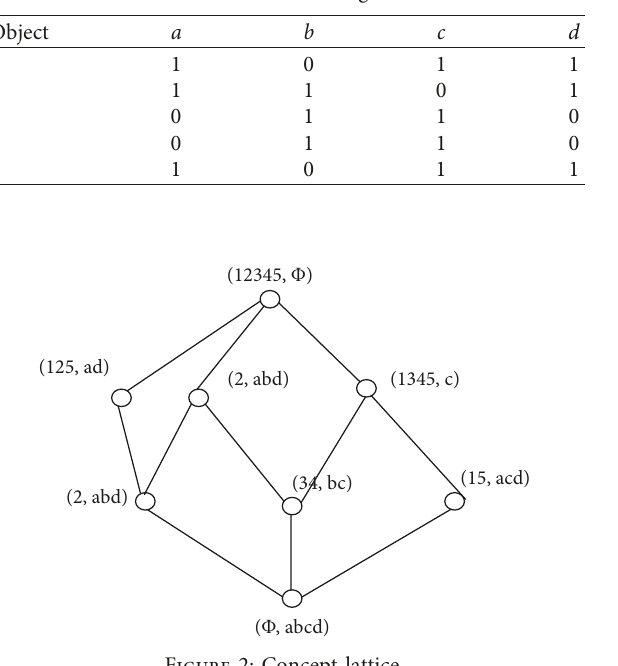
Figure 1: Data cube lattice. Table 2: A formal background.